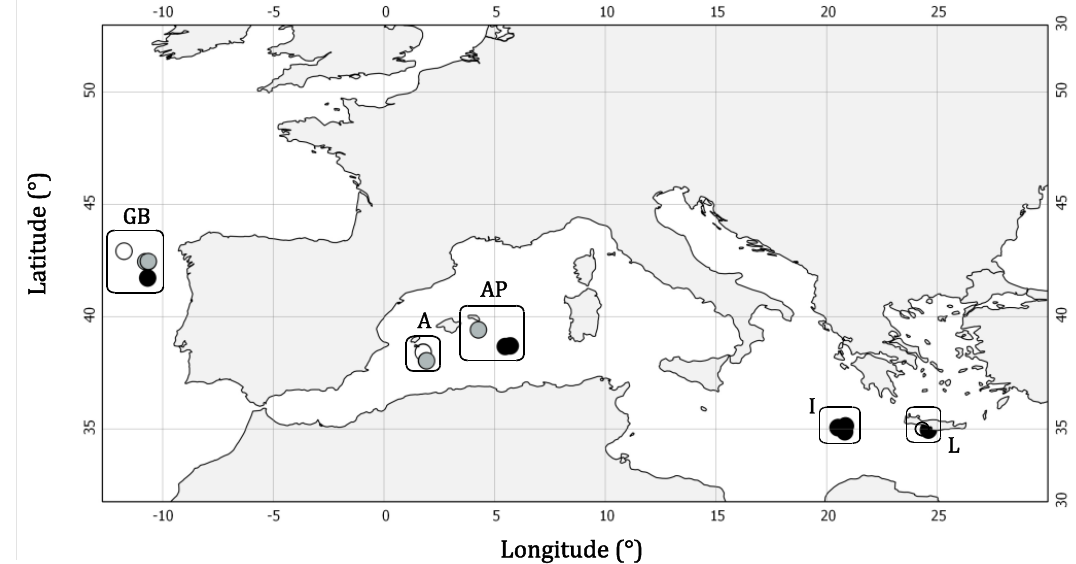
Fig. 1. Map with sampling locations. Colours indicate approximate water depth (white: 1200 m, grey: 1900 m, black: 3000 m). The rectangles enclose samples that were collected within the same region (GB: Galicia Bank region, A: Algerian basin, AP: Algero-Provençal basin, I: Ionian basin and L: Levantine basin).